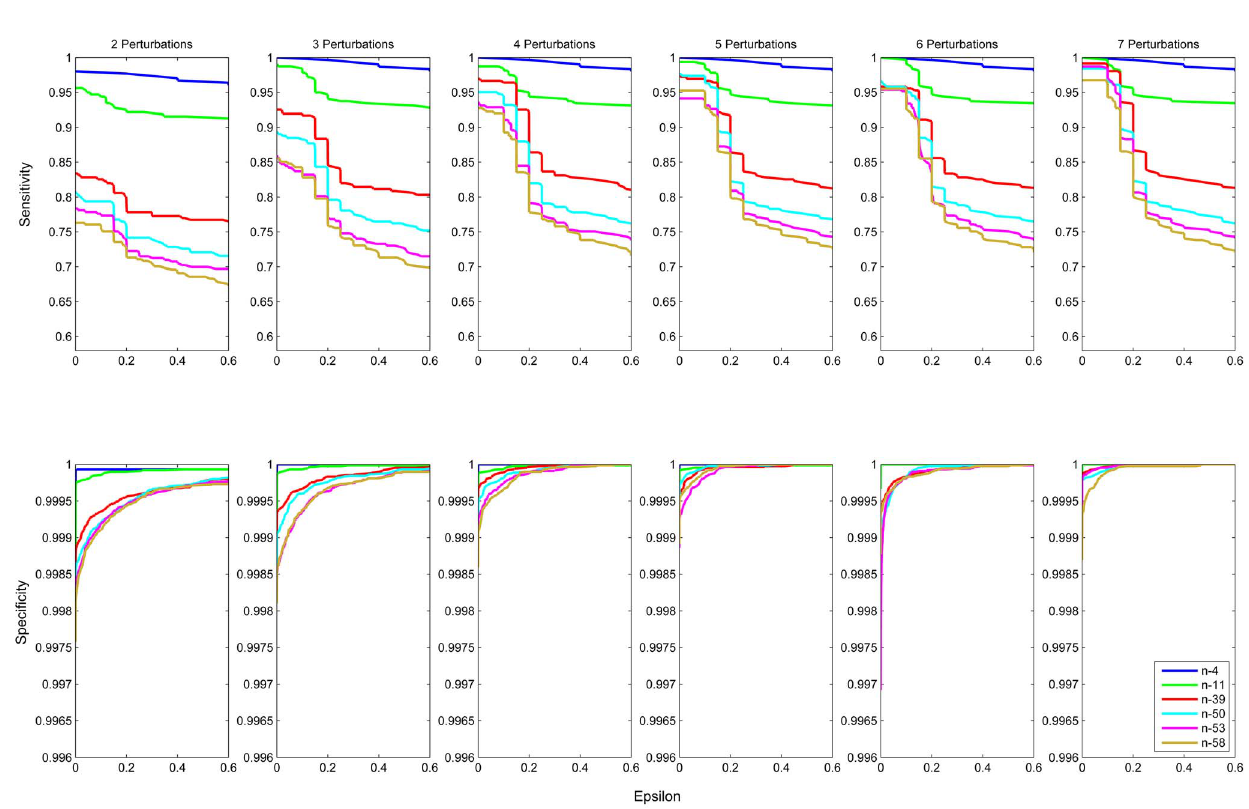
Figure 6. Sensitivity/specificity v.s. threshold parameter. These graphs show the relationships between sensitivity (above) and specificity (below) and threshold parameter E for 6 different benchmark networks with different numbers of perturbations varying from 2 to 7. For E ~ 0 , the average specificity is 0.9989 and the average sensitivity reaches its maximum value of 0.9453. When E increases to 0 : 2 , the average specificity is 0.9999 and the average sensitivity decreases to 0.8742. If E increases to a relatively large value 0 : 6 , the average specificity achieves 1.000 but the average sensitivity becomes 0.8188.